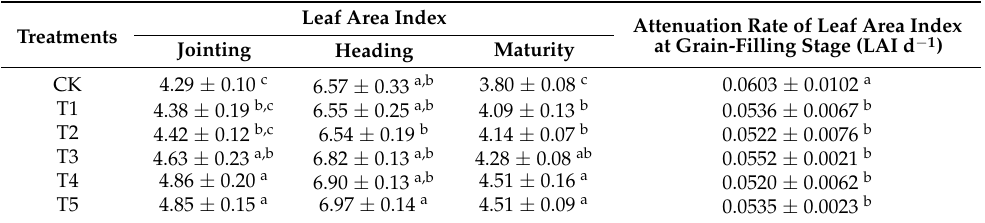
Table 4. Leaf area index and attenuation rate of leaf area at grain-filling stage of rice under different ZnO NPs application amounts.